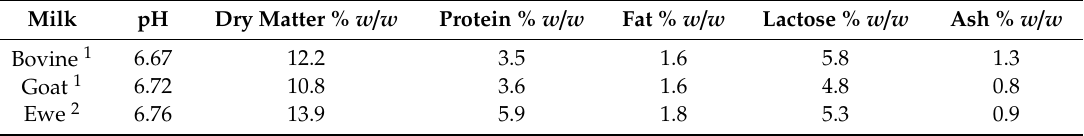
Table 1. Physicochemical characteristics of the di ff erent milks used for the assessment of the clotting activity of aqueous extracts from Onopordum tauricum